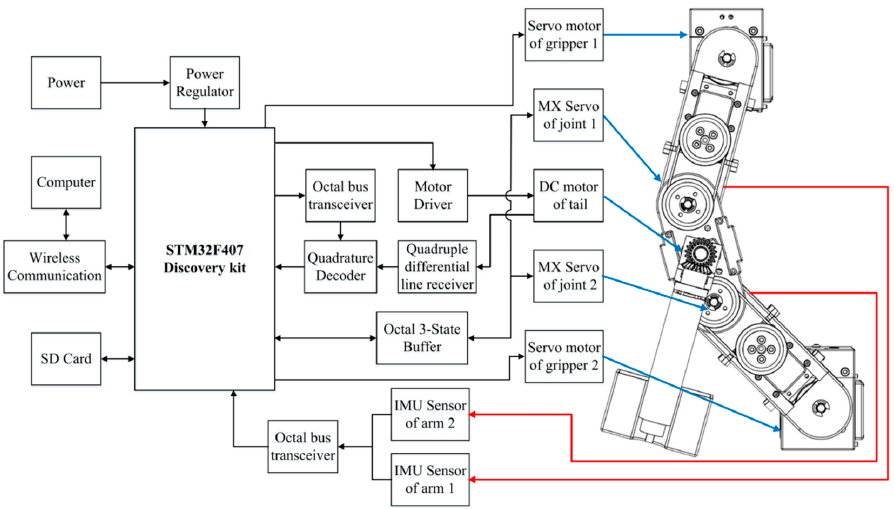
Figure 9. Hardware used in the implementation of the robotic control system.